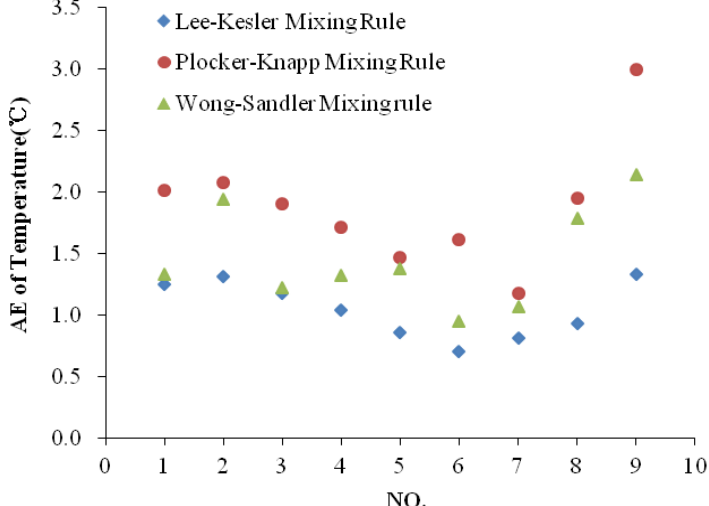
Figure 1. Absolute errors of temperatures between HYSYS and the prediciton model with different mixing